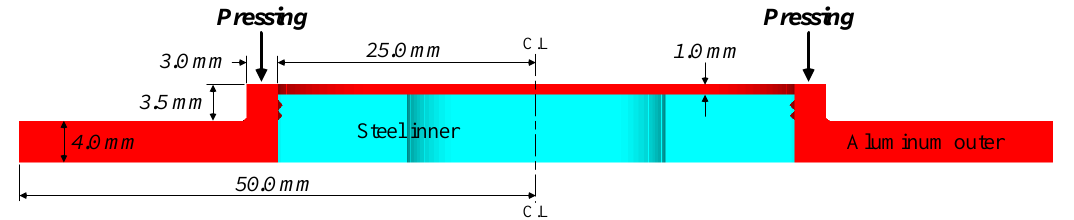
Figure 6. Shape and dimensions of aluminum outer.